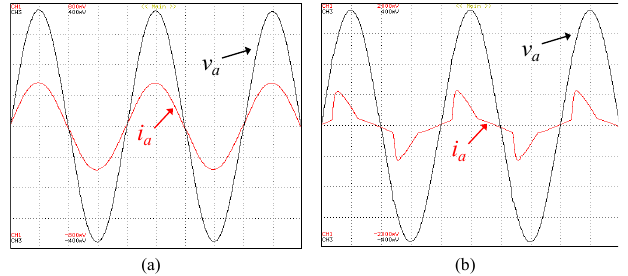
Figure 8. Experimental results of the produced voltage ( v a ) and consumed current ( i a ) during the V2H mode as UPS considering: (a) Linear electrical appliances; (b) Nonlinear electrical appliances.